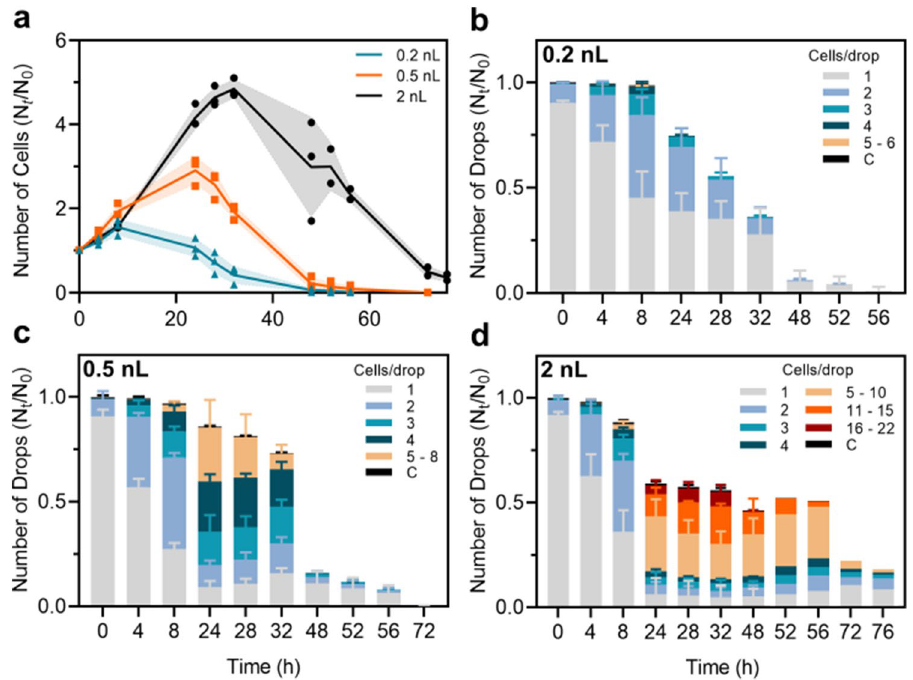
Figure 3. Survival and growth of encapsulated T.b. brucei . ( a ) Comparison of cell survival, defined as normalized total cell number, between droplet sizes of 0.2 nL (blue), 0.5 nL (orange) and 2 nL (black) over time. Supporting the cell survival data is the presentations of growth over time defined as normalized number of drops containing a given number of cells in 0.2nL drops ( b ), 0.5 nL drops ( c ) and 2nL drops ( d ). All results are presented as mean values ±SD. Experimental data from 0.2 nL, 0.5 nL and 2 nL drops (0–48 h) are made as biological replicates (n = 3). For 2 nL drops at time 52 to 76 h n = 2. Significance values supporting the survival differences observed in ( a ) are presented in Table 1, 2 and